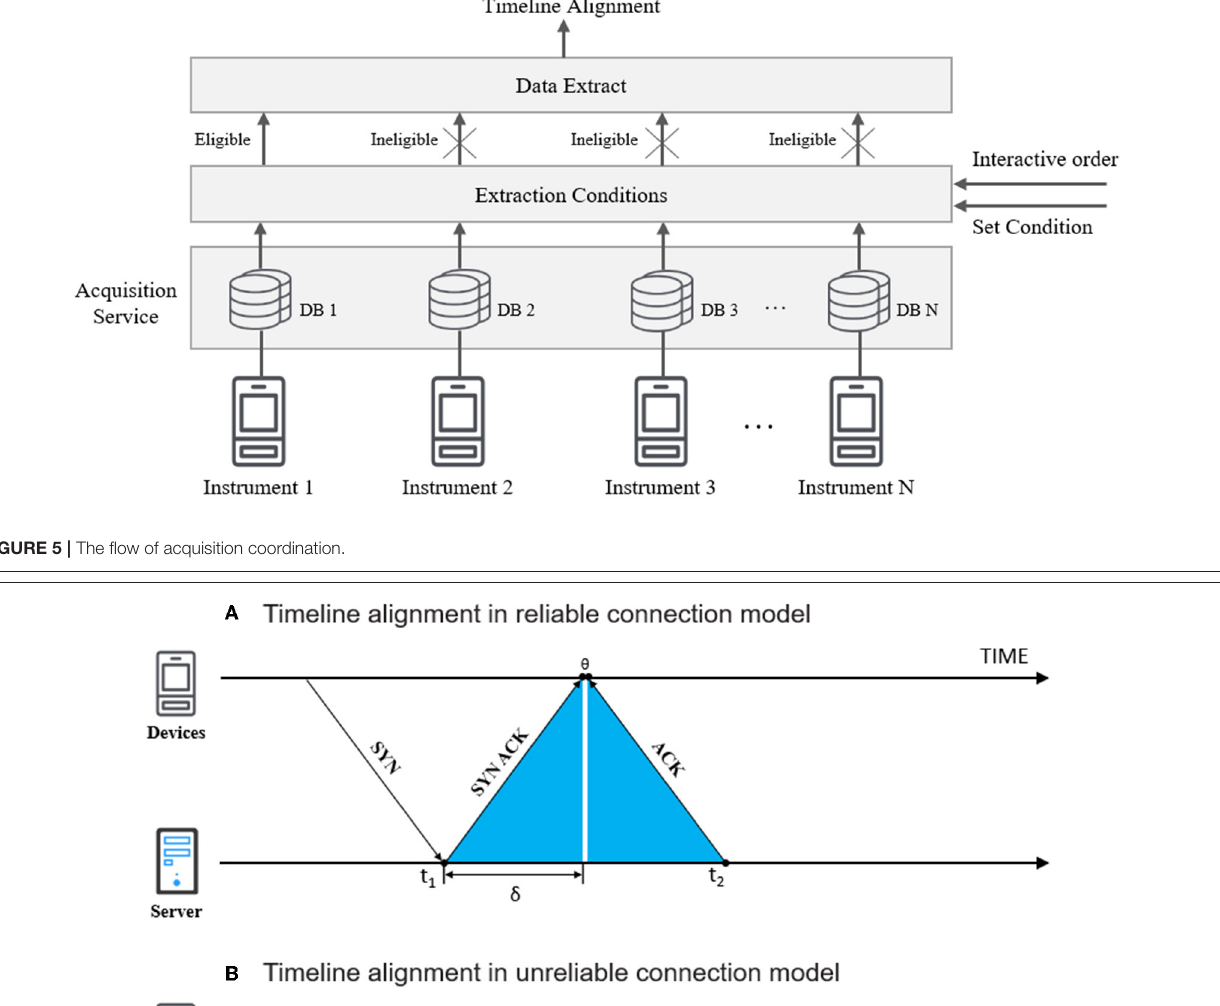
frequency, the instrument processing time ( 2 ) can also be first 10 data packets or more, the network transmission in-transit delay is calculated as δ . In this situation, the δ value is equal